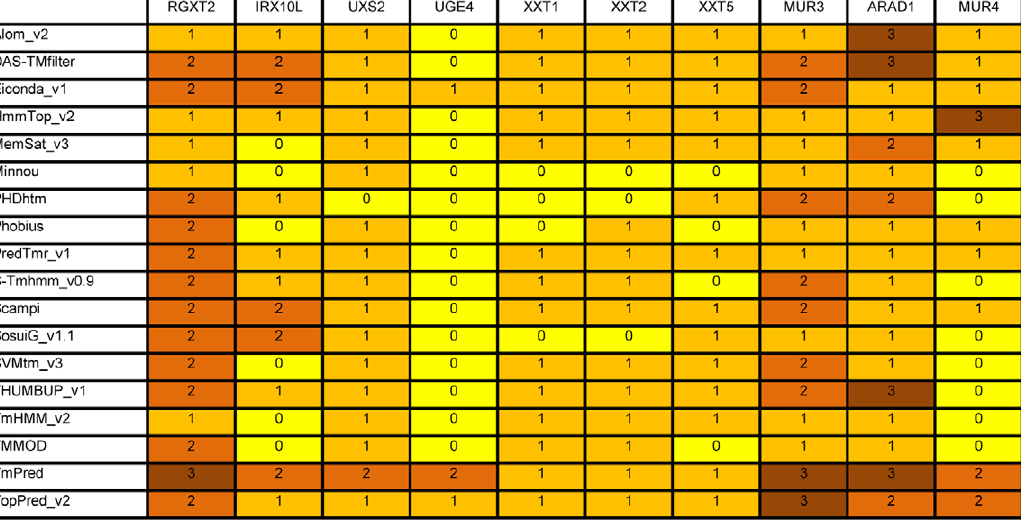
Figure 4. Prediction of the number of transmembrane domains for selected cell wall biosynthetic enzymes. The data compiled in Aramemnon (http://aramemnon.uni-koeln.de/) is summarized. Numbers indicate the number of transmembrane domains.